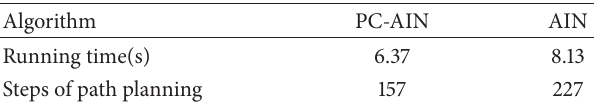
Table 1: Performance comparison of AIN and